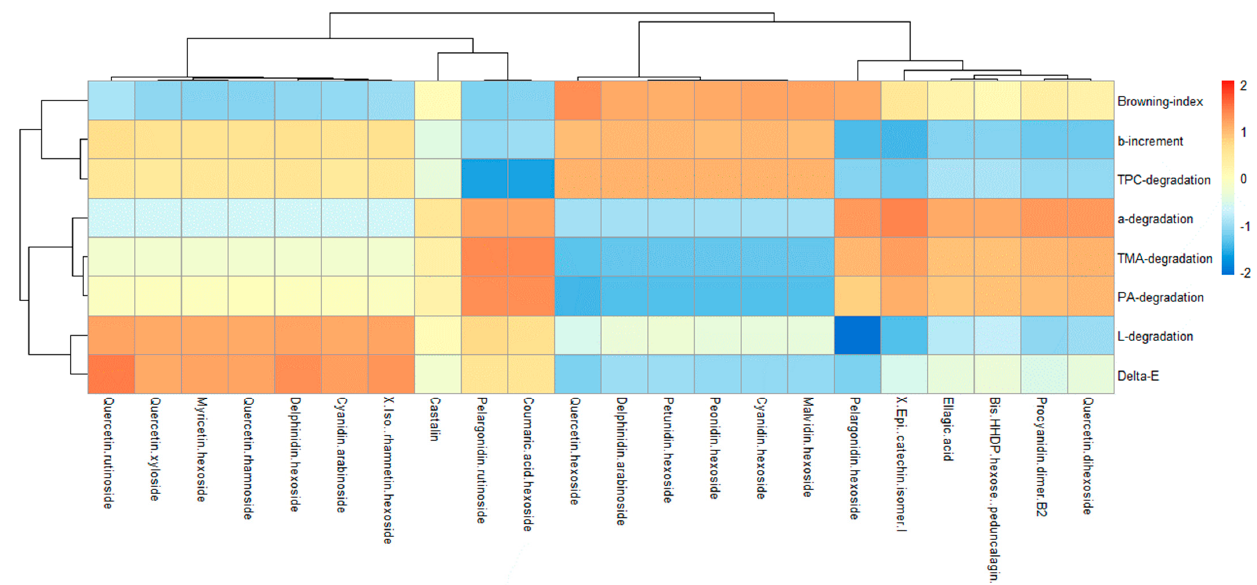
Figure 3. Correlation heatmap between the polyphenol profile of berry-based beverages and their color and polyphenol degradation during storage under commercial conditions. TPC: Total phenolic compounds; TMA: total monomeric anthocyanins; PA: proanthocyanidins.